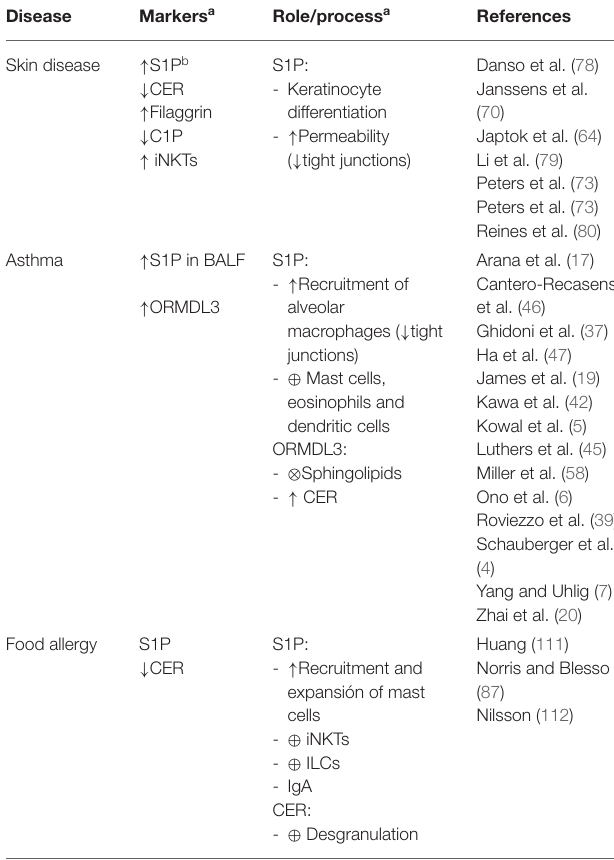
TABLE 2 | Role of sphingolipids in allergic